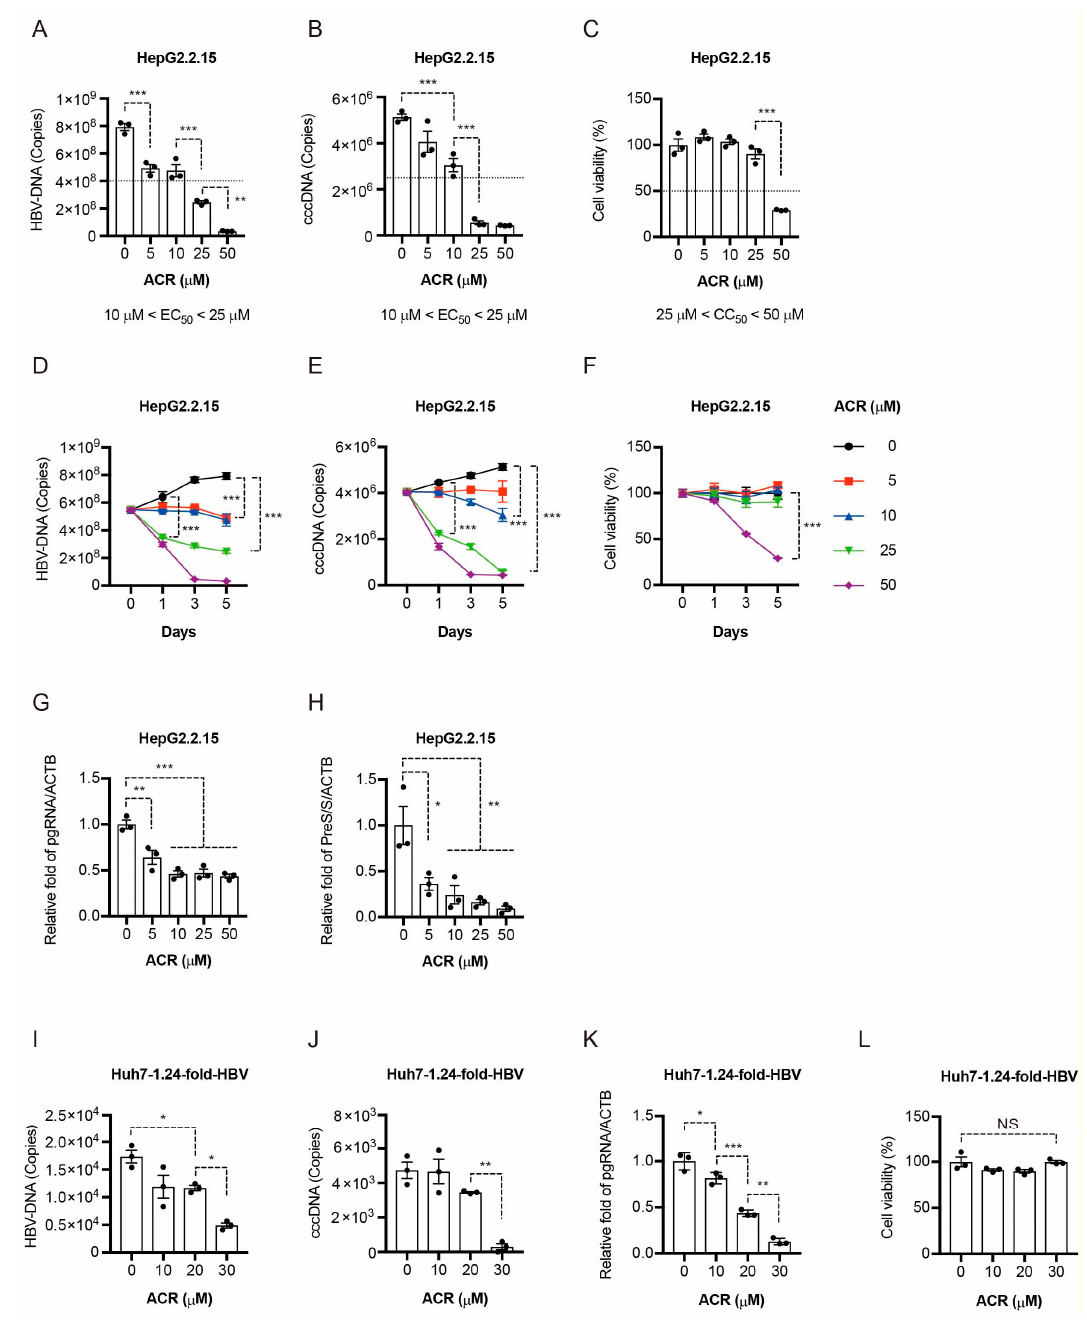
Figure 1. Peretinoin inhibits HBV replication. ( A – H ) HepG2.2.15 cells were treated with 0, 5, 10, 25, or 50 μ M of peretinoin for 5 days. ( A ) HBV-DNA levels were analyzed by qPCR. ( B ) cccDNA levels were analyzed by qPCR. ( C ) Cytotoxicity was analyzed by MTT assay after the inoculation of peretinoin for 5 days. ( D ) Time-dependent effect of peretinoin on HBV-DNA. ( E ) Time-dependent effect of peretinoin on cccDNA. ( F ) Time-dependent effect of peretinoin on cytotoxicity. ( G ) Pregenomic RNA levels of HBV were analyzed by RTD-PCR, and pregenomic RNA levels were normalized against the β -actin mRNA level. ( H ) PreS/S RNA levels were analyzed by RTD-PCR, and PreS/S RNA levels were normalized against the β -actin mRNA level. ( I – L ) A plasmid encoding 1.24-fold-HBV was transfected into Huh7 cells and 24 h after transfection, 0, 10, 20, or 30 μ M of peretinoin was added for 5 days. ( I ) HBV-DNA levels were analyzed by qPCR. ( J ) cccDNA levels were analyzed by qPCR. ( K ) Pregenomic RNA levels of HBV were analyzed by RTD-PCR. ( L ) Cytotoxicity was analyzed by MTT assay after the inoculation of peretinoin for 5 days. The data are represented as means ± SEM from three independent experiments. * p < 0.05, ** p < 0.01, *** p < 0.001.